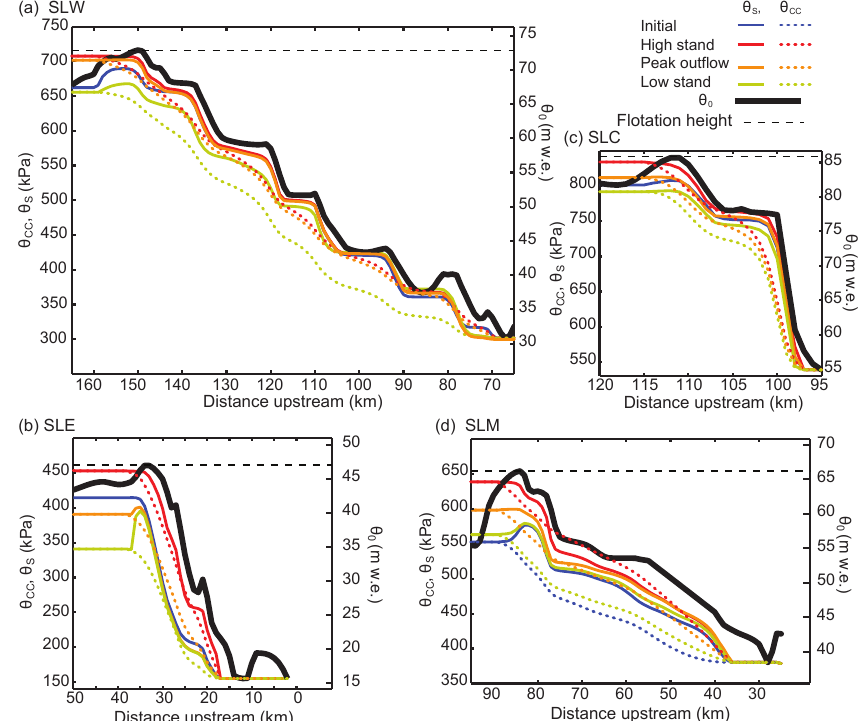
Figure 3. Along-flow hydropotential (left axis) in the distributed (solid) and channelized (dotted) drainage systems at four important time steps during a fill–drain cycle (initial state, highstand, peak outflow, low stand) for the four main lakes in the Whillans–Mercer subglacial system: (a) SLW, (b) SLE, (c) SLC, and (d) SLM. Thick black line (right axis) indicates overburden pressure calculated using Eq.